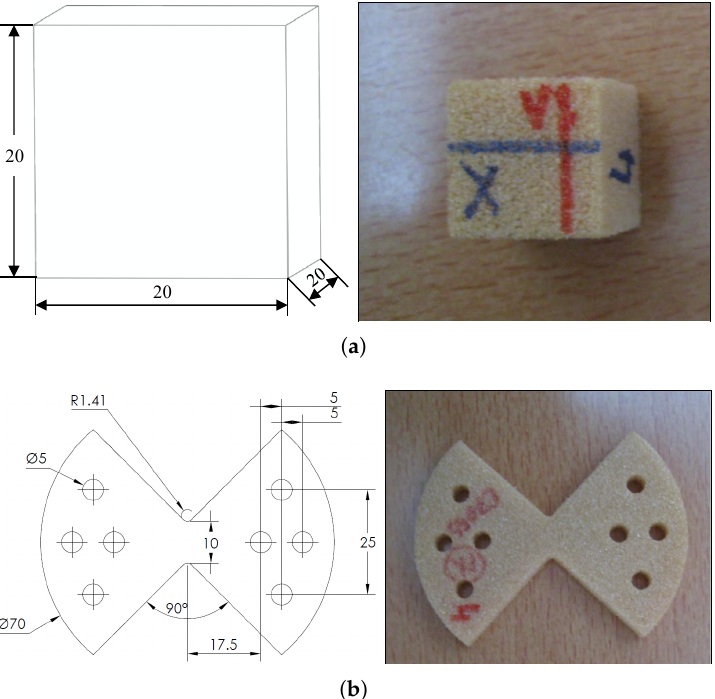
Figure 15. Illustration of ( a ) the cubic specimen for the compression test and ( b ) the “Batman”-shaped specimen for the shear